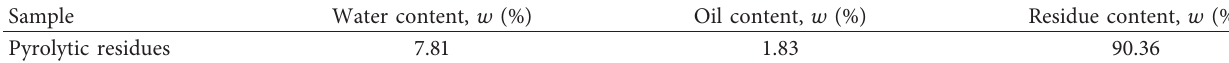
Table 1: Contents of pyrolytic residues.